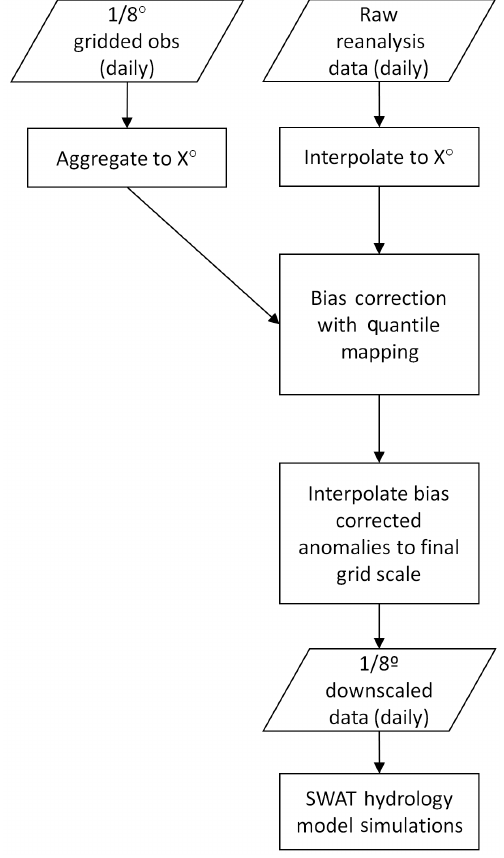
Figure 1. Schematic of bias correction–spatial disaggregation pro- cess used in this experiment. Values for X vary from 2 ◦ (latitude- longitude) to 0.125 ◦ as described in the